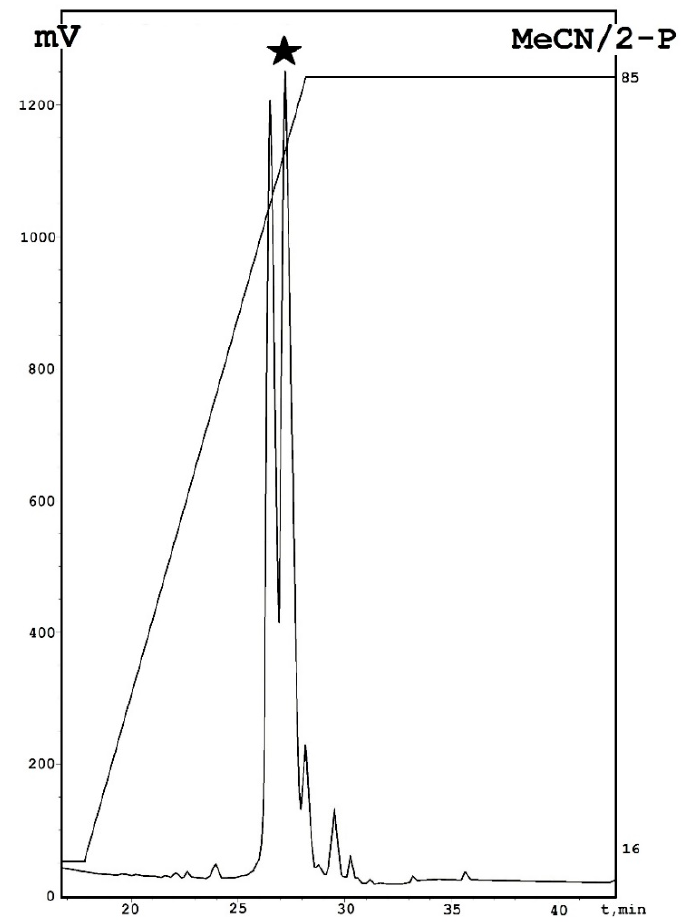
Figure 1. Purification of emericellipsin A by phenyl-modified reversed-phase HPLC. The target peak was marked by a black star. Specific descriptions: MeCN—acetonitrile; 2-P—isopropanol.